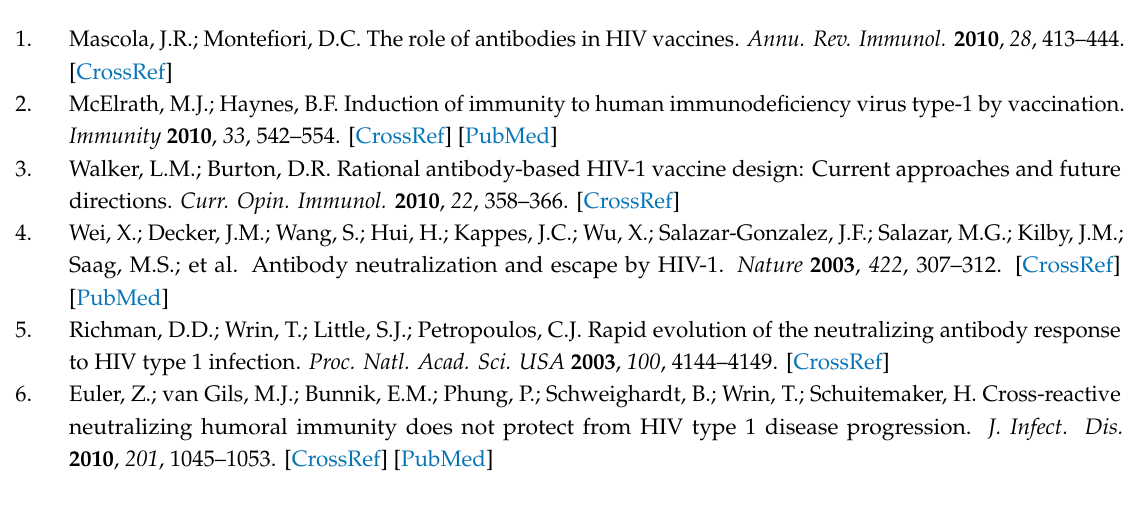
Table S1: Serum neutralization capacity of MSM and IDU of the Amsterdam